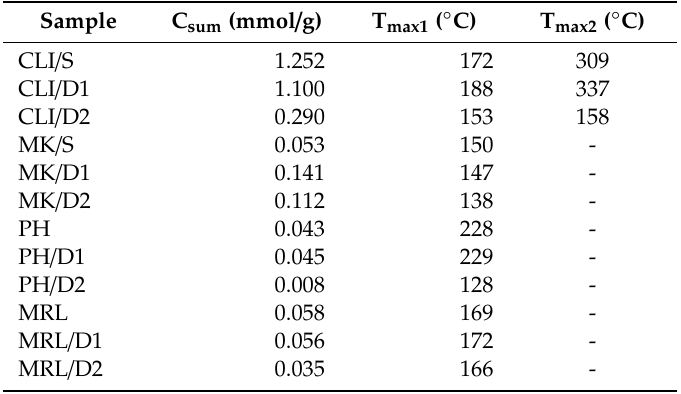
Table 2. The total acidity of natural materials determined by the NH 3